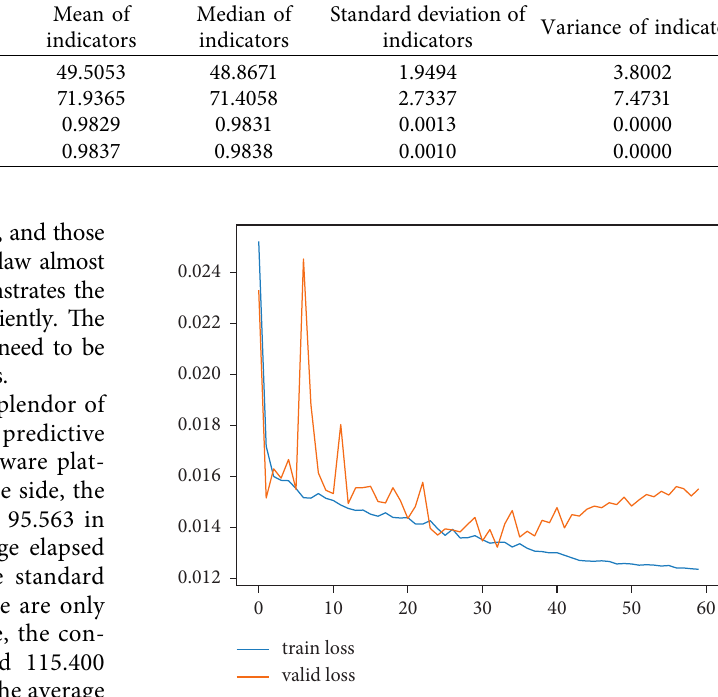
Figure 11: A deficient FEB-LCR-ACM validating loss curve by